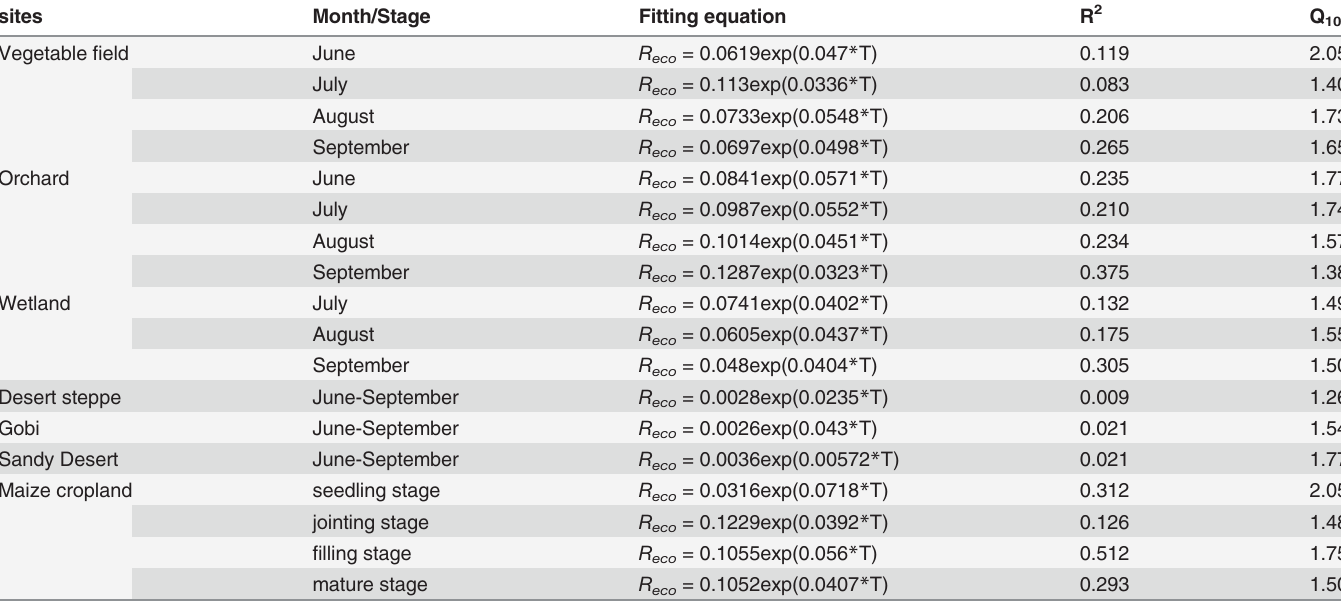
Table 3. The relationship between nighttime ecosystem respiration and air temperature for different ecosystems. sites Month/Stage Vegetable fi eld